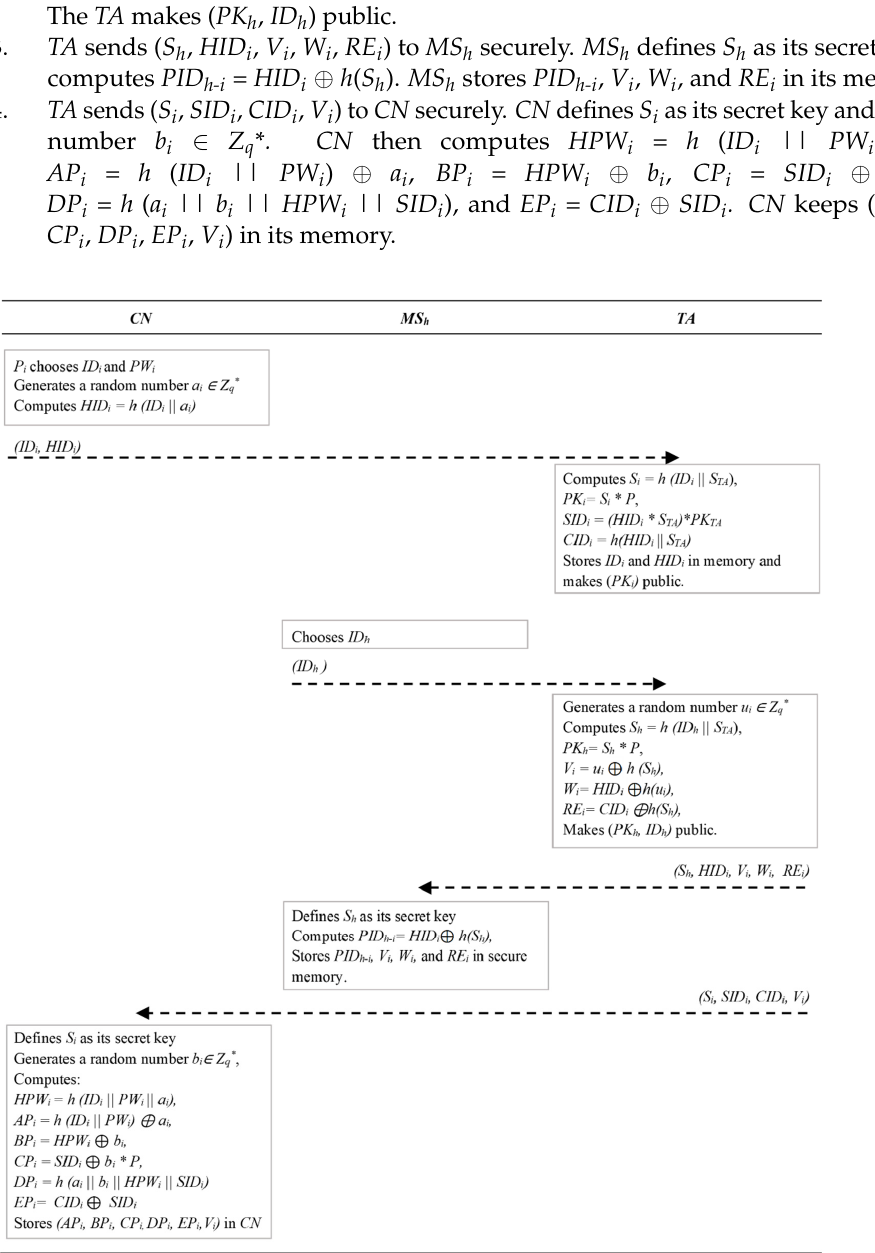
Figure 3. Registration